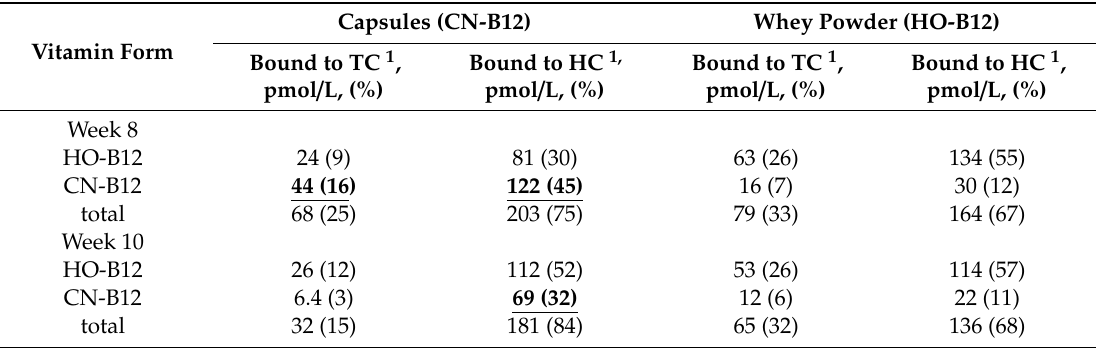
Table 3. Distribution of CN-B12 and HO-B12 on transcobalamin (TC) and haptocorrin (HC) at the end of the intervention (week 8) and two weeks post-treatment (week 10) in the groups treated with CN-B12 in capsules or HO-B12 in whey